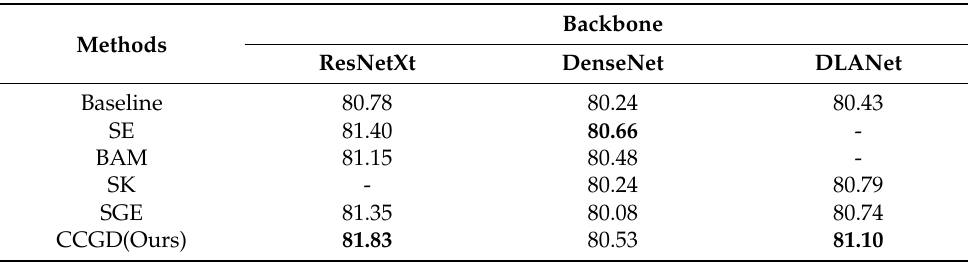
Table 2. Performance comparisons of different models on the Ciafr100 dataset. Results in bold are the best in each column.